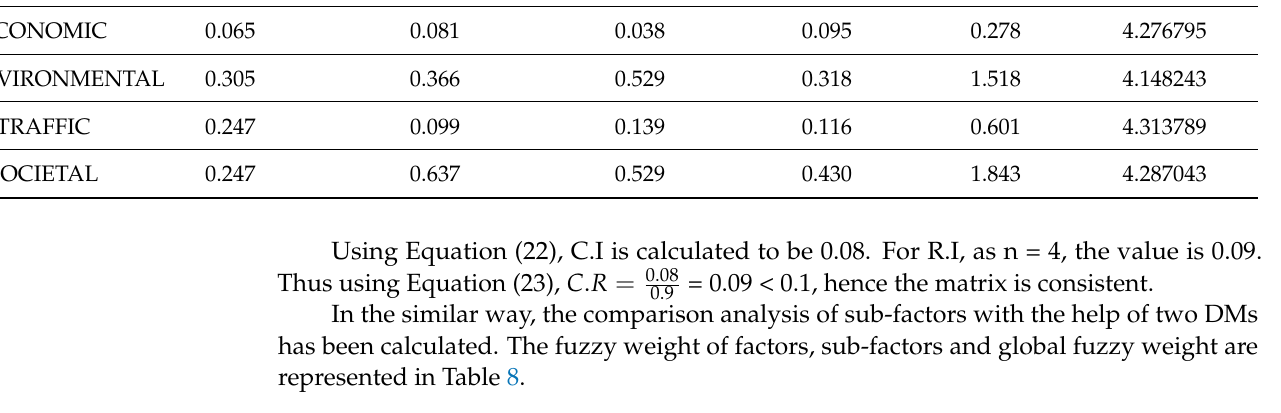
Table 8. Hexagonal fuzzy weights of factors, sub-factors and global